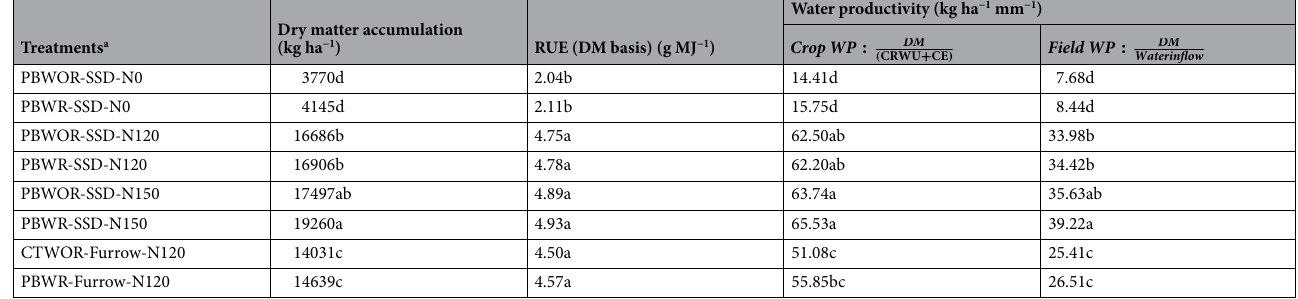
Table 3. Dry matter accumulation, radiation use efficiency (RUE) and water productivity of maize under different tillage, crop residue, nitrogen and irrigation management treatments during the simulation period (8–89 DAS). Means followed by different lowercase letter within each column are significantly different (at P < 0.05) according to least significant difference test. a For treatment detail please see Table